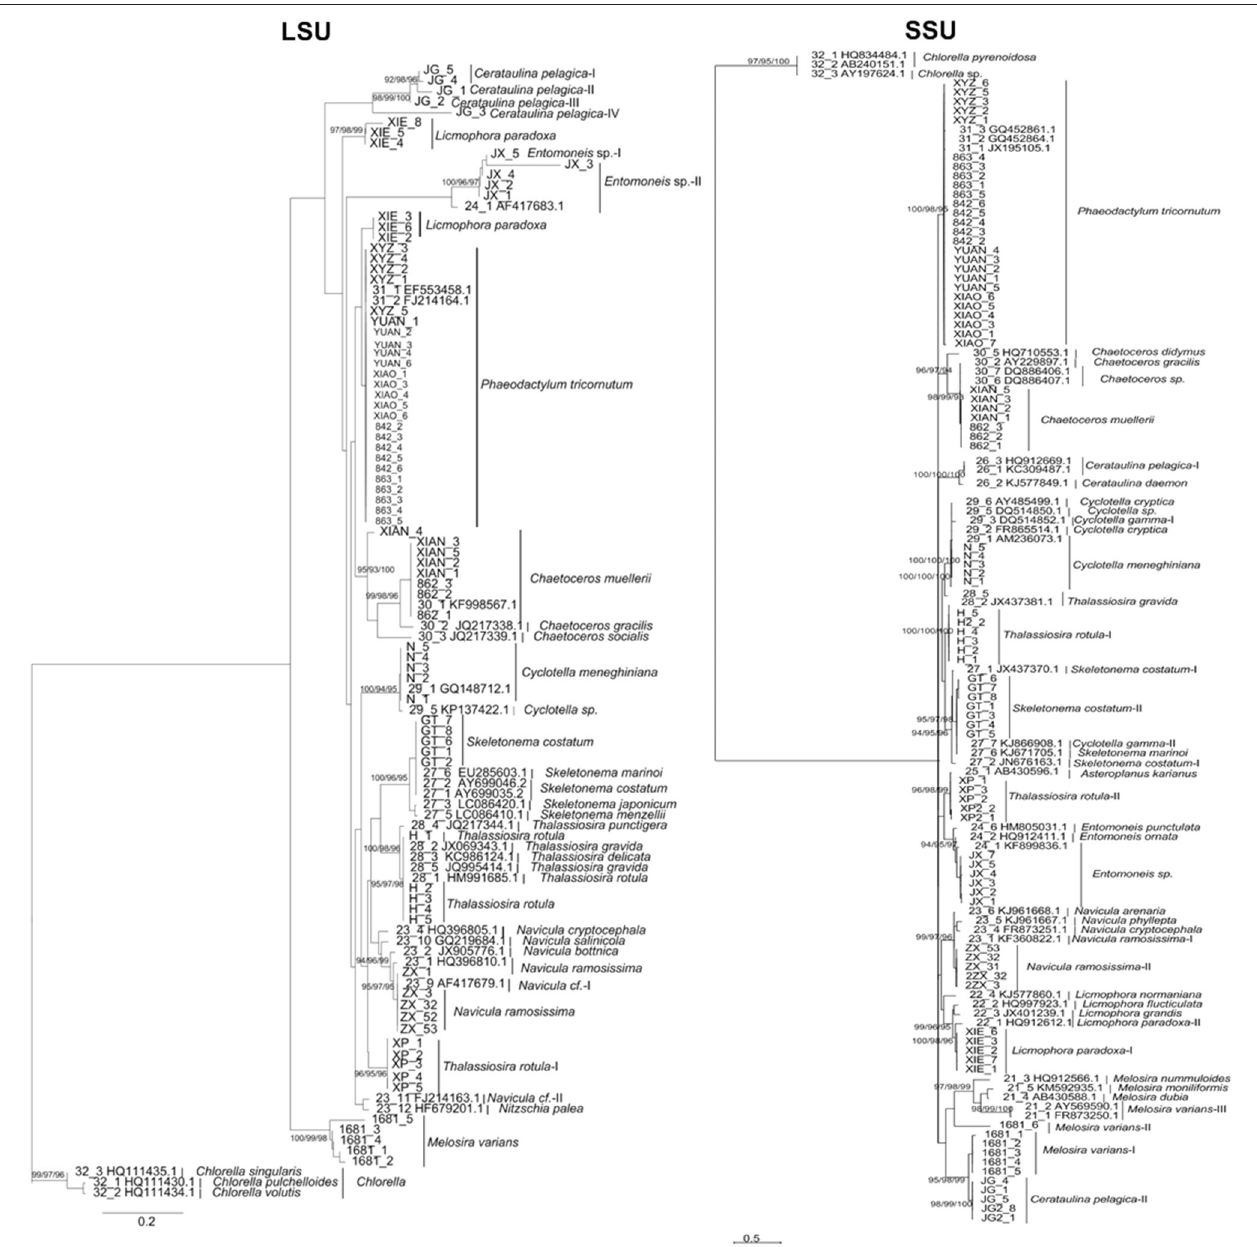
FIGURE 3 | Bayesian phylogenetic trees for the LSU and SSU genes. The NJ, Bayesian and Maximum Likelihood bootstraps are indicated for species clades recovered, where the order is NJ/Bayesian/ML. Some potential cryptic species revealed are indicated by species name (I, II, III…). For sequences downloaded from NCBI, their GenBank numbers are shown besides the name of